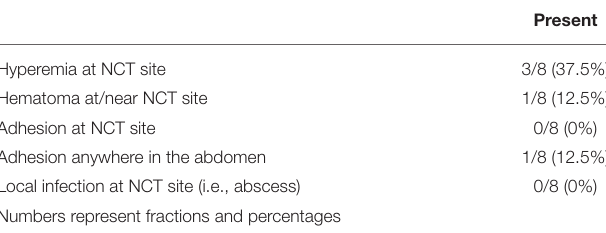
TABLE 1 | Frequency of assessed morbidity associated with NCT application to Jejunal